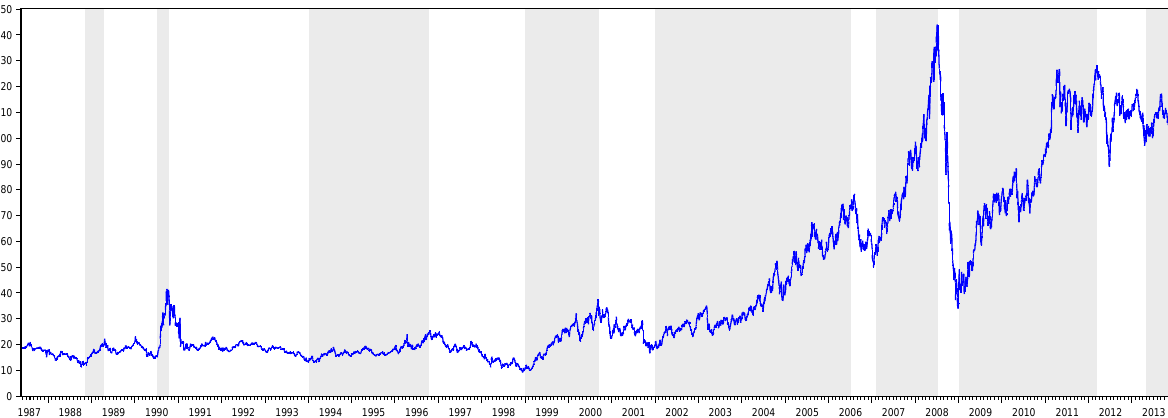
Figure 1. Bull and bear periods of the oil